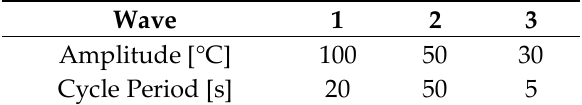
Table 1. Amplitude and cycle period of three waves